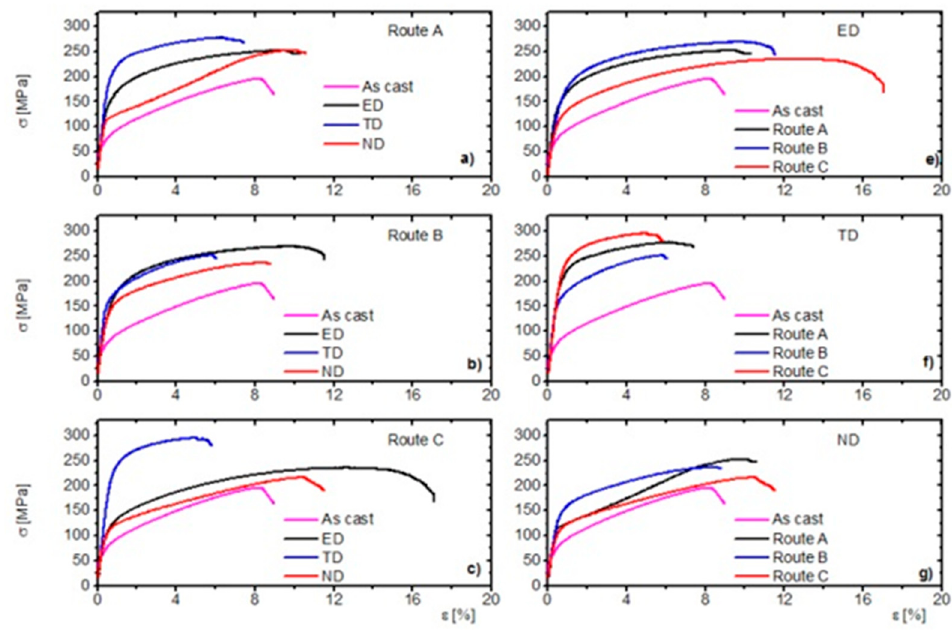
Figure 6. Stress-strain curves ( a – c ) for particular routes as a function of the tensile direction and ( e – g ) for the particular directions as a function of ECAP